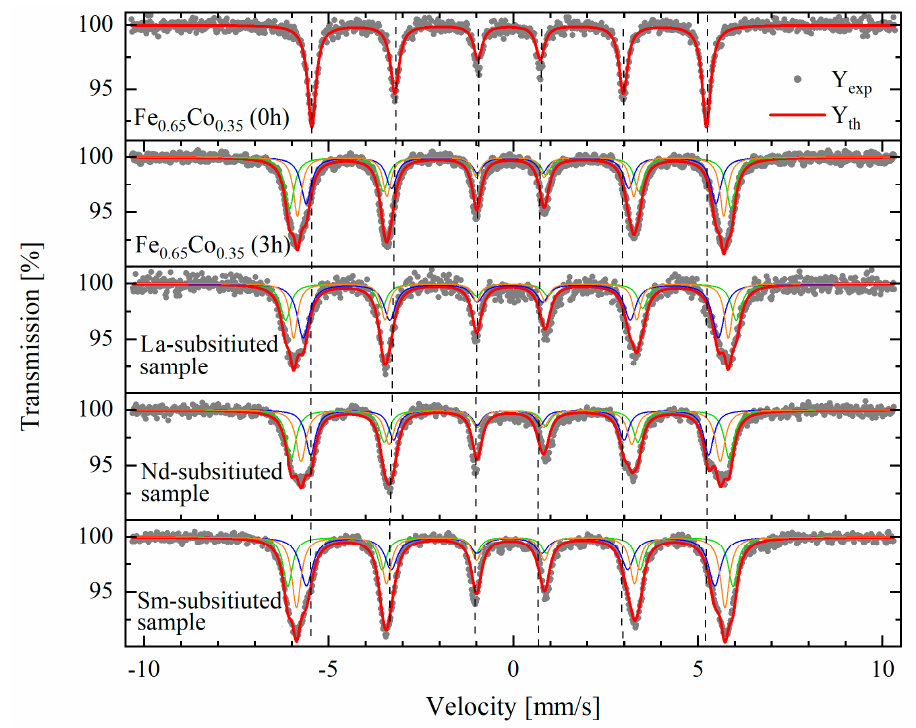
Figure 6. Mössbauer spectra of the base sample of Fe 0.65 Co 0.35 (0 h), Fe 0.65 Co 0.35 (3 h) alloy, and (Fe 0.65 Co 0.35 ) 0.95 ( RE 2 O 3 ) 0.05 samples with RE = La, Nd, and Sm milled for 3 h. Full circles - measured data; blue, orange and green - three fit components; red - resulting fit.